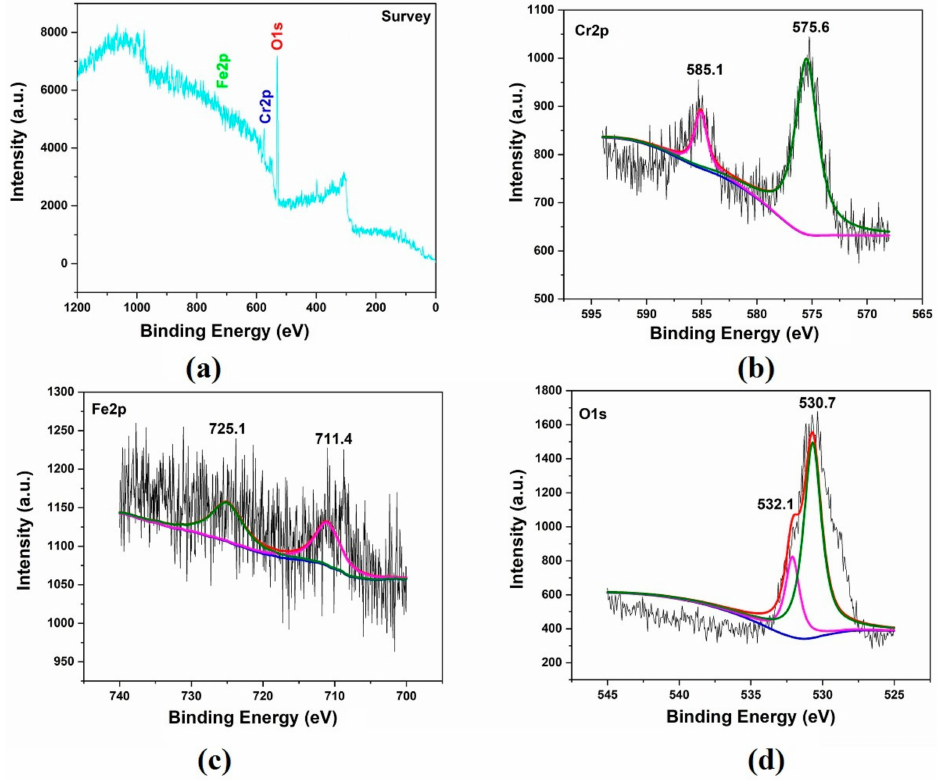
Figure 5. XPS spectra of: ( a ) survey, ( b ) Cr2p, ( c ) Fe2p and ( d ) O1s from the 2#